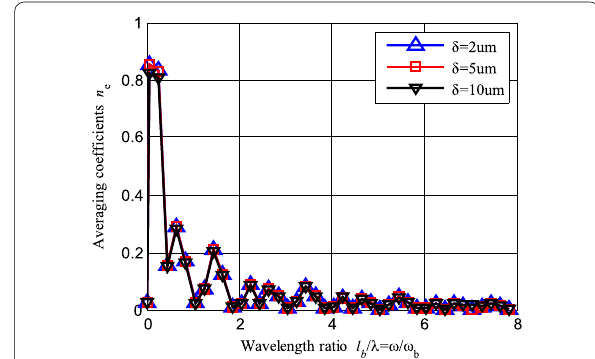
Figure 11 Averaging coefficient curves for different wavelengths